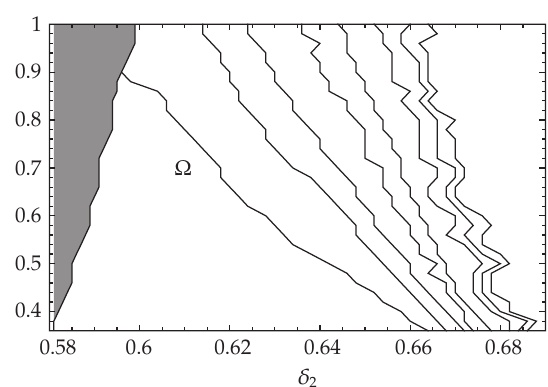
Figure 8: Periodic orbits (cid:3) n ≤ 5 (cid:4) of the turning point C in the Ω region. From right to left, the corresponding kneading sequences are as follows: C ∞ , (cid:3) RC (cid:4) ∞ , (cid:3) RLRC (cid:4) ∞ , (cid:3) RLRRC (cid:4) ∞ , (cid:3) RLC (cid:4) ∞ , (cid:3) RLLRC (cid:4) ∞ , (cid:3) RLLC (cid:4) ∞ , and (cid:3) RLLLC (cid:4) ∞ . The parameter values in the grey region do not correspond to unimodal maps and are beyond the scope of our study.